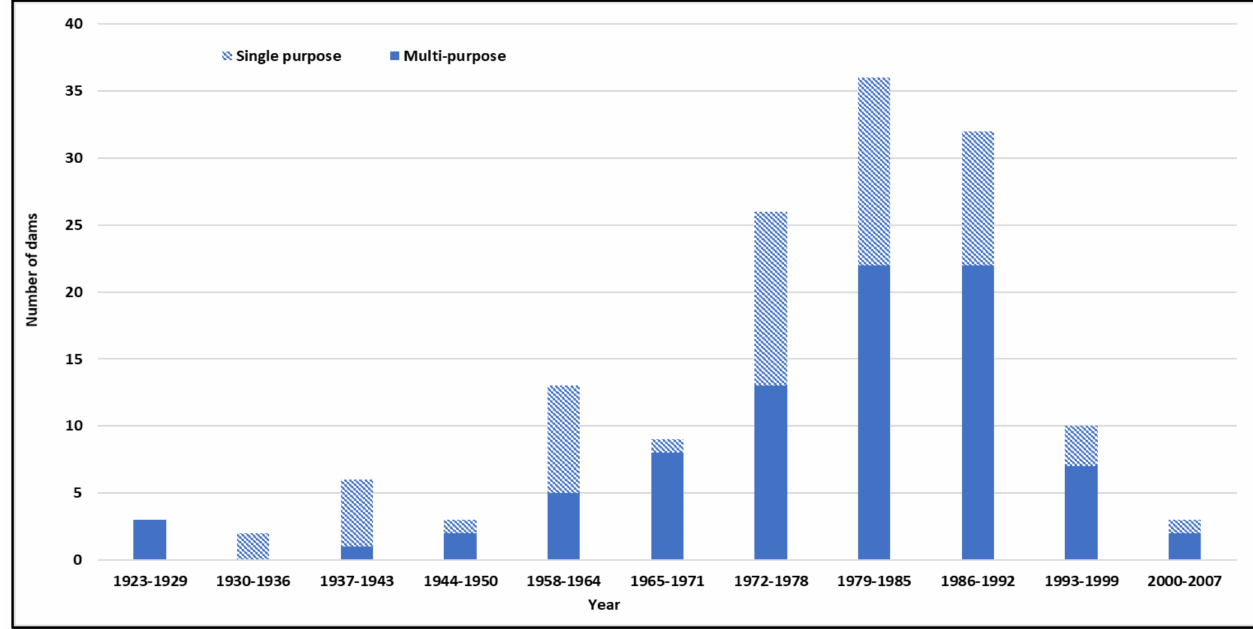
Figure 4. Distribution and trend of multi-purpose and single-purpose dams 1923–2007